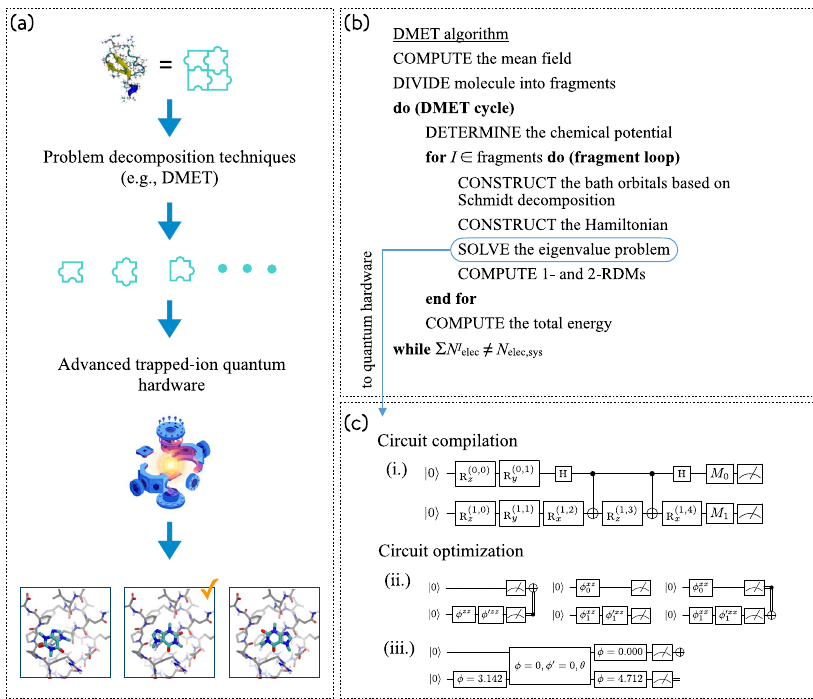
Fig. 1 Problem decomposition-based pipeline for ef fi cient electronic structure simulation on a quantum computer. a Schematic illustration of the pipeline. b The density matrix embedding theory (DMET) algorithm. “ 1- and 2-RDMs ” refers to one- and two-particle reduced density matrices. c Pre- and post-optimizing compilation circuits. (i) Pre-optimizing compilation input, with the gates M 0 and M 1 chosen appropriately for the different measurement bases. (ii) Post-optimizing compilation outputs for the three output circuits for ZZ (left), XZ (middle), and XX (right). Note that XZ and ZX result in the same circuit, outside of the relabeling of the qubit indices. See Supplementary Tables 3 and 4 for the numerical values of the gate parameters. (iii) Post- optimization circuits for YY, required for the classical post-processing of our simulation data. See Supplementary Table 5 for the numerical values of the gate